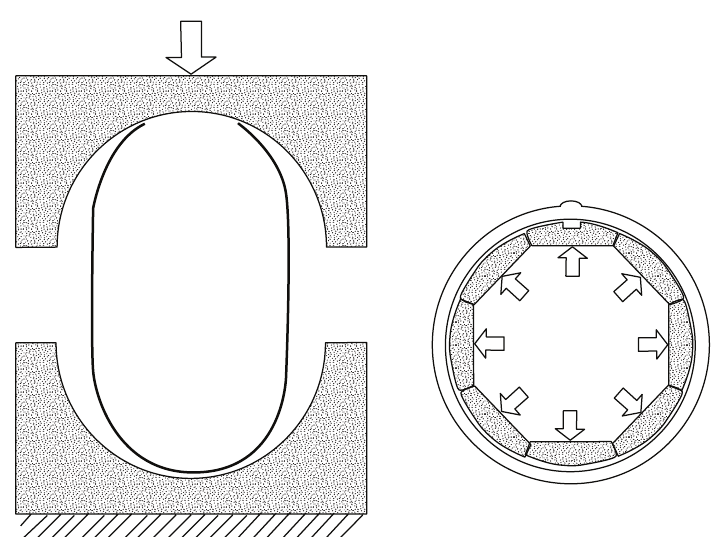
Figure 1: Schematic UOE forming steps.